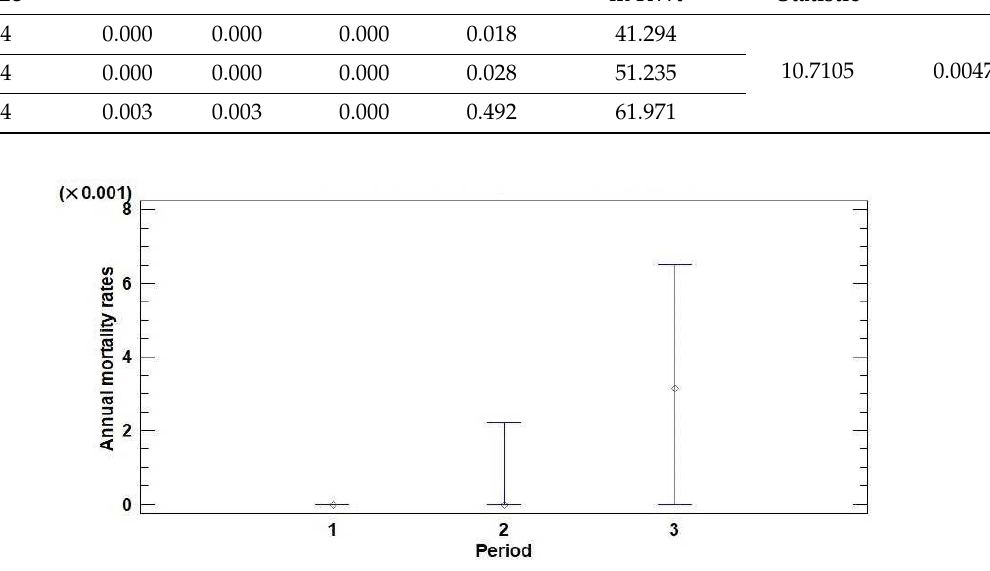
Figure 2. Median plot with 95% confidence intervals for the annual mortality rates of trees